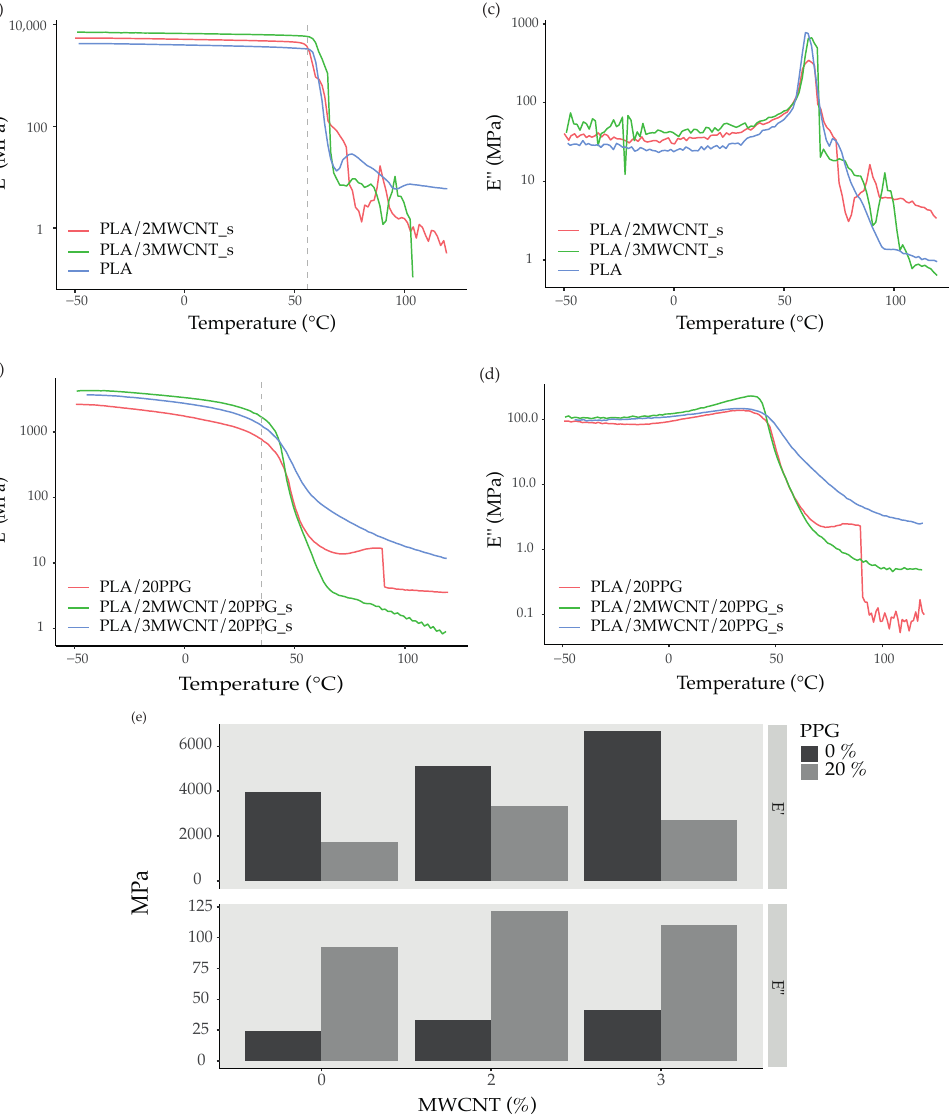
Figure 8. ( a ) Storage modulus G (cid:48) curves of neat PLA and PLA-MWCNT composites, and ( b ) PLA composites with plasticizer. ( c ) Loss modulus G” curves of neat PLA and PLA-MWCNT composites, and ( d ) PLA composites with plasticizer. ( e ) E (cid:48) and E” at 0 ◦ C of PLA and